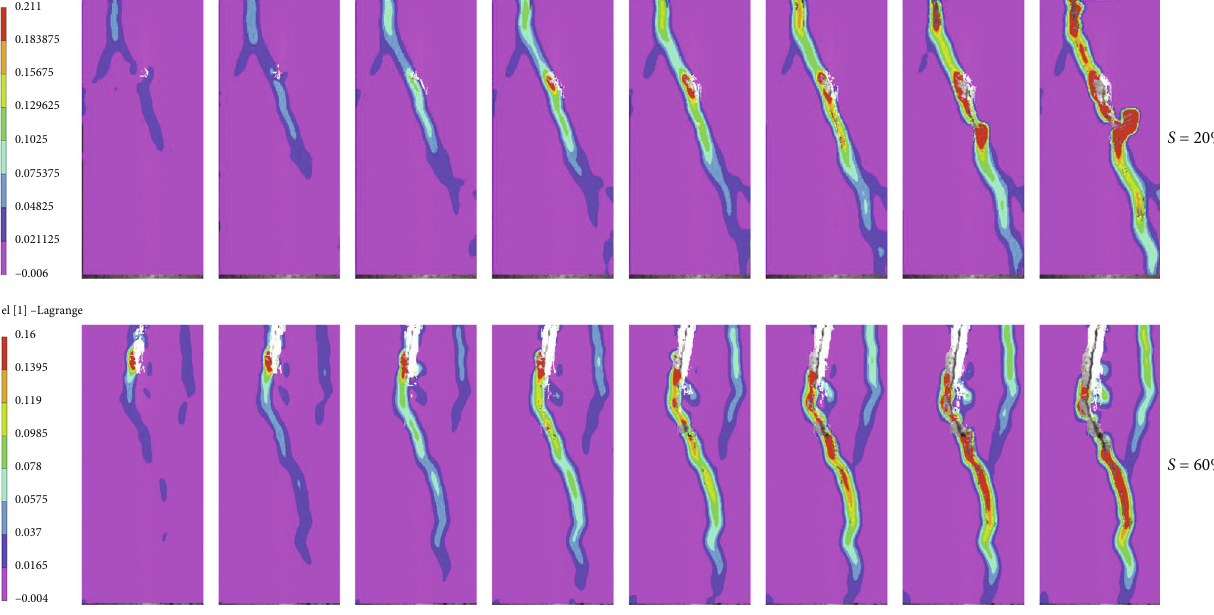
Figure 15: main strain nephogram of the crack development process with S = 20 % and S = 60 %